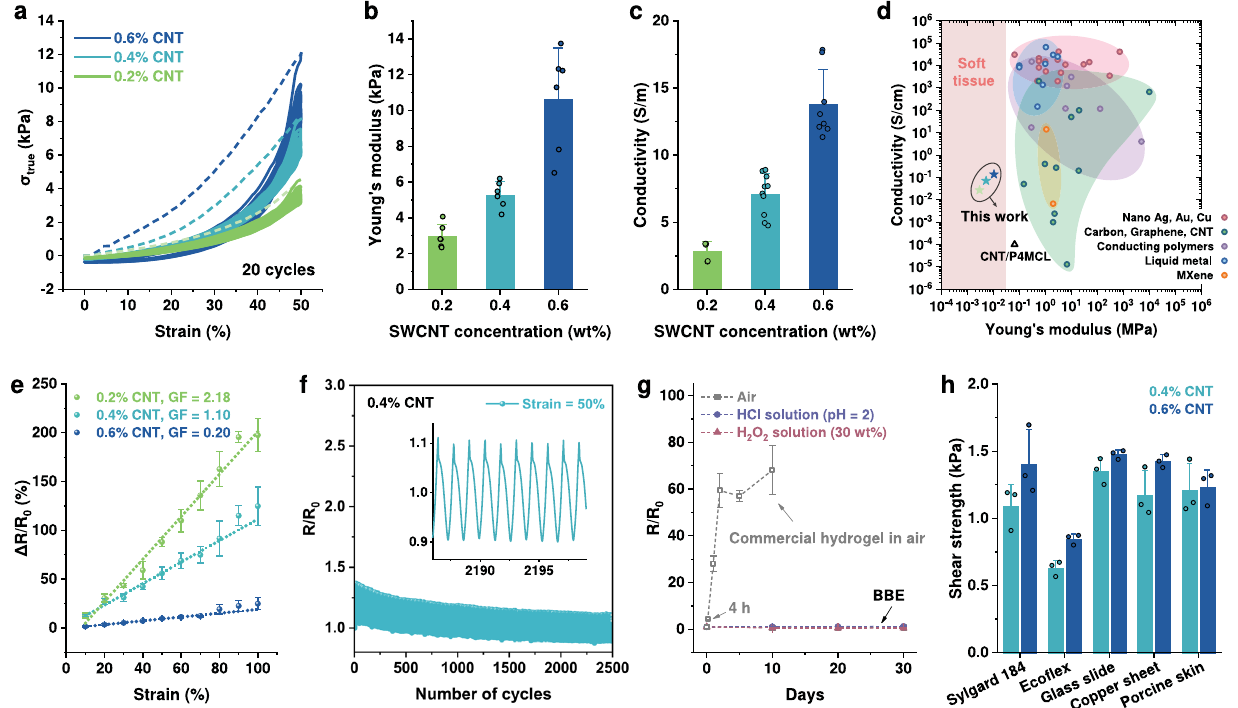
Fig. 3 | CharacterizationoftheconductiveSWCNT/BBE.a Cycling testsofPDMS BBEswith0.2wt%,0.4wt%,and0.6wt%SWCNTatthestrainof50%.20cycleswere conducted, with the fi rst half cycle represented by the dash line. b The Young ’ s modulus and c conductivity of PDMS BBEs with 0.2wt%, 0.4wt%, and 0.6wt% SWCNT. d The Ashby-style plot of the conductivity and Young ’ s modulus of dif- ferentconductiveelastomerswithmetallicnanomaterials,carbon-basedmaterials, conducting polymers, liquid metal, or MXene as conductive components. Hydro- gelsarenotincludedastheycontainwaterandarenotsolvent-free.Datapointsare